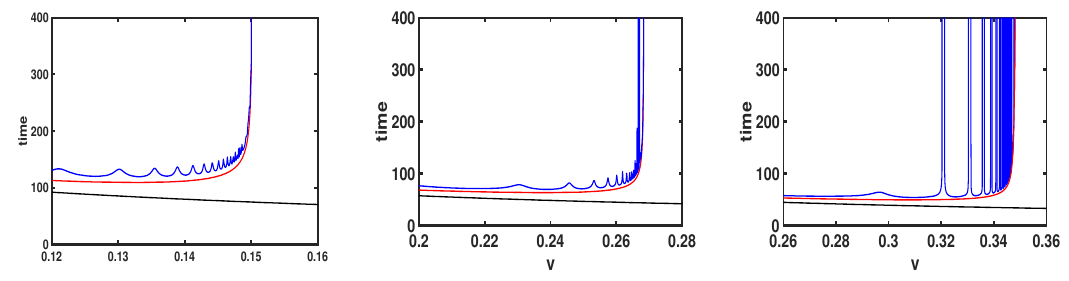
Figure 21 . Small kink-antikink collision: time to first (black), second (red) and third (blue) bounces for kink-antikink colisions as a function of initial velocity for (a) r = 0 . 05, (b) r = 0 . 1 and (c) r = 0 .